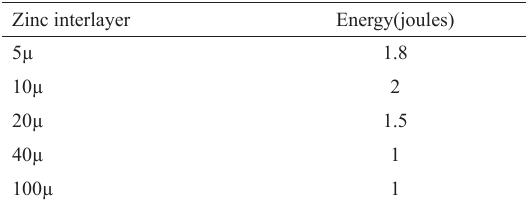
Figure 6: SEM images of (a) advancing side, (b) stir zone and (c) retreating side Al7020 joint with 20µ zinc Table 4: Impact energy results.